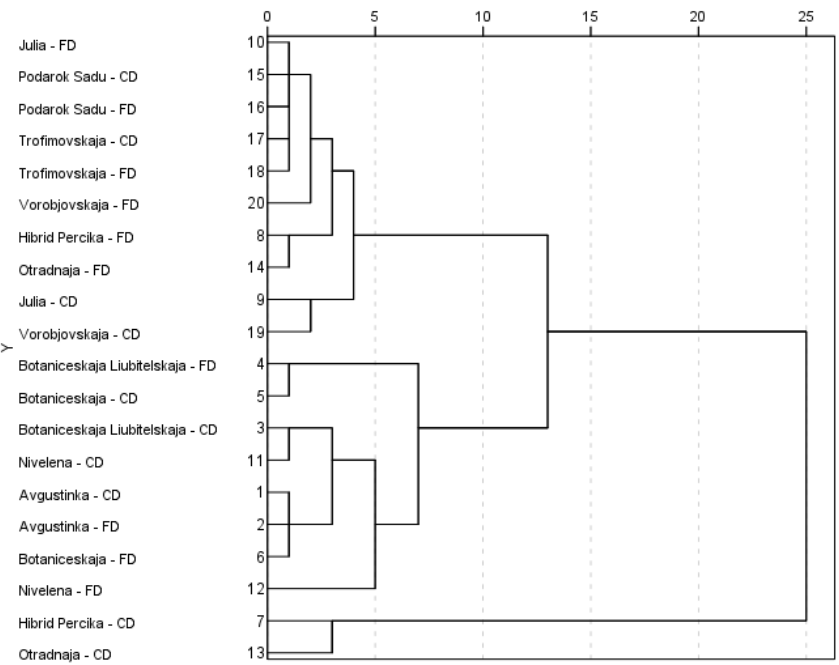
Figure 4. The dendrogram of hierarchical cluster analysis on phenolic and triterpenic compounds of convection-dried (CD) and freeze-dried (FD) HR cultivars’ leaf powders. 1–cluster composed of CD and FD samples of ‘Avgustinka’, ‘Botaniceskaja’, ‘Botaniceskaja Liubitelskaja’, and ‘Nivelena’; 2–cluster composed of CD samples of ‘Hibrid Percika’ and ‘Otradnaja’; 3-cluster composed of CD and FD samples of ‘Julia’, ‘Podarok Sadu’, ‘Trofimovskaja’, ‘Vorobjovskaja’, and FD samples of ‘Hibrid Percika’ and ‘Otradnaja’.